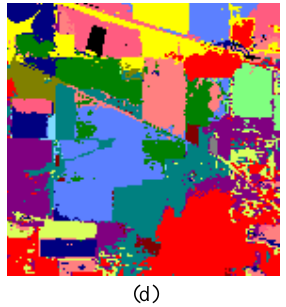
Fig. 3. (a) Three-band colour composite of the Indian Pines image. (b) The result map of NO. 1. (c) The result map of NO. 2. (d) The result map of NO. 3.